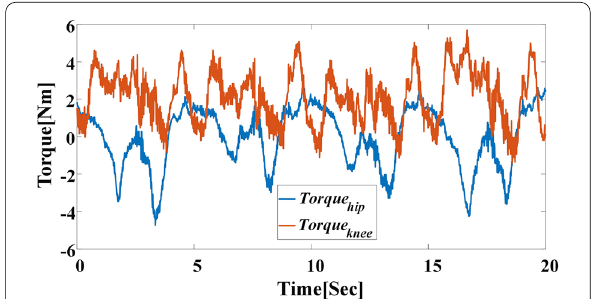
Figure 12 Human-robot interaction torque by using the backstepping controller in exoskeleton passive